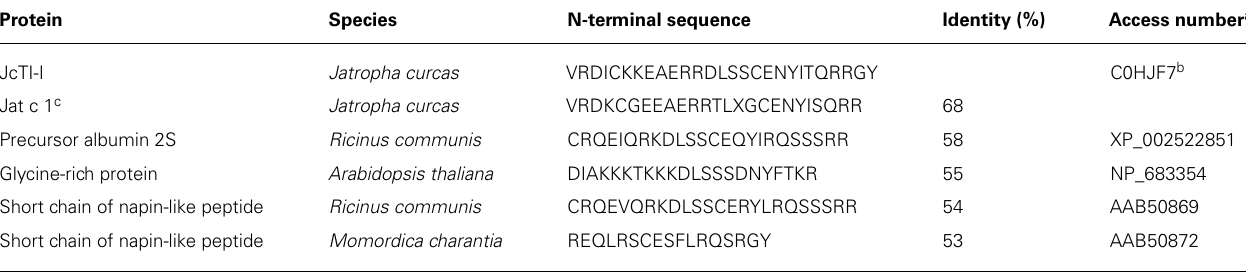
Table 2 | Comparison of N-terminal sequence of JcTI-I with similar protein sequences.